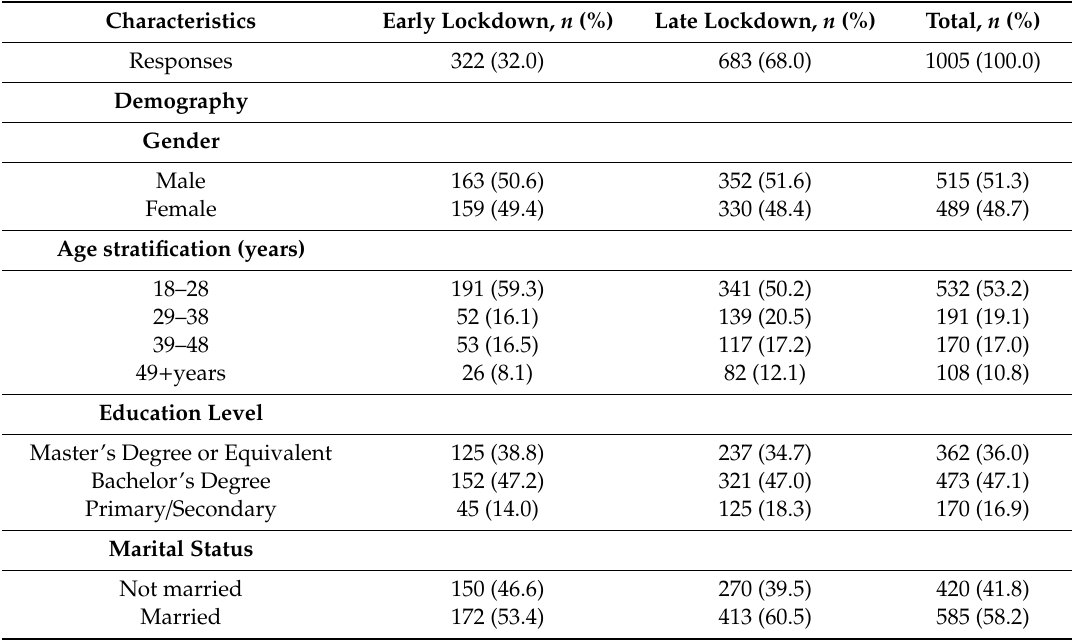
Table 2. Sociodemographic characteristics of the